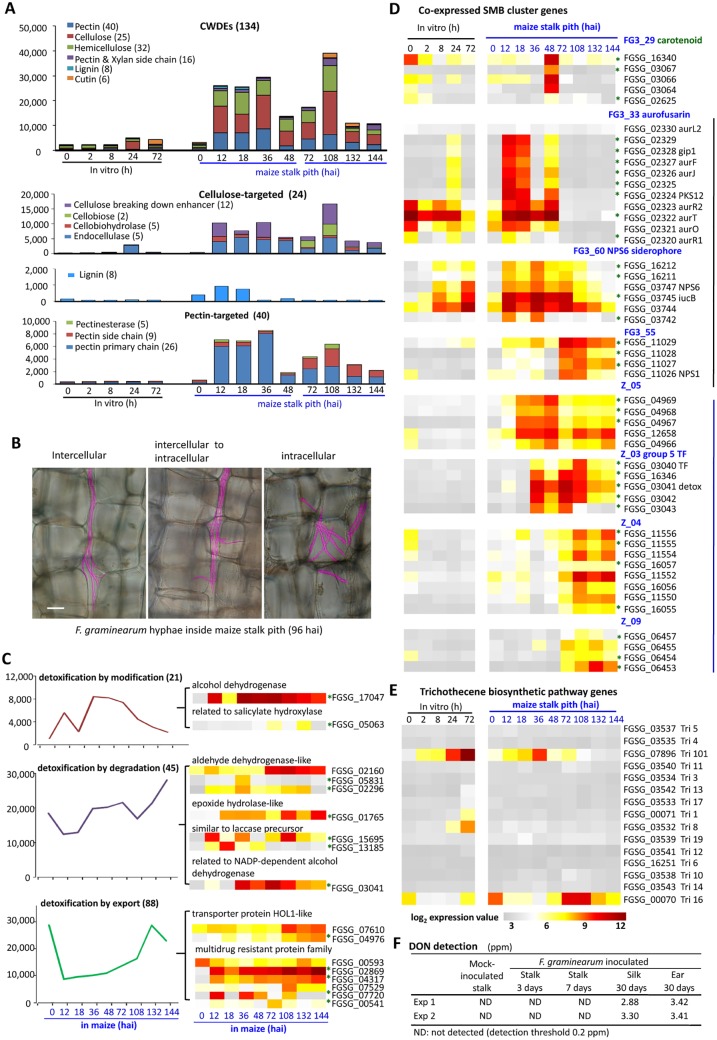
Time course of expression of genes potentially involved in plant cell wall degradation, detoxification, and secondary metabolite biosynthesis.(A) Expression of cell wall degradation-related genes grouped based on putative targeted components of plant cell wall. Total signal intensities for the genes in the denoted group are charted. (B) Hyphae in the pseudo pink color represent various growth path. (C) Expression patterns of detoxification-related genes grouped based on FunCat annotations. Total signal intensities for all genes in the denoted group are charted. The number of genes included in each category is indicated in parentheses. (D)-(E) Expression of several secondary metabolite biosynthesis clusters. hai: hours after inoculation. Genes significantly up-regulated in at least one time point but not up-regulated in spores are labeled with green asterisks. (F) DON detection in maize tissue extracts. ppm = mg/kg.